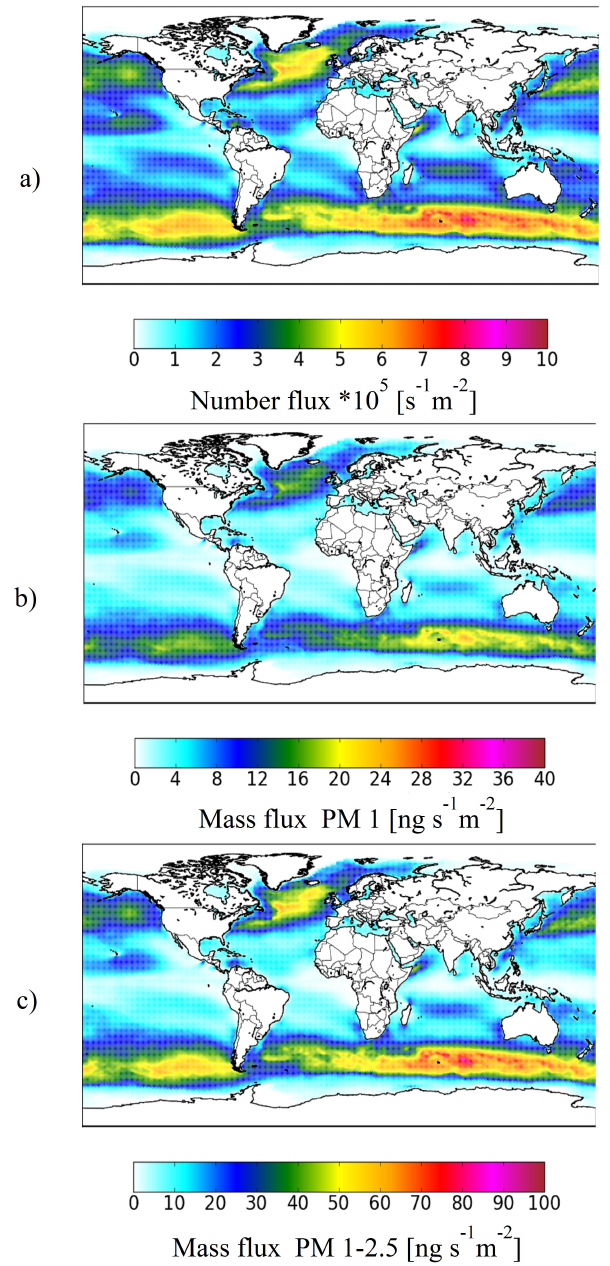
Fig. 9. Annual mean production flux of SSA computed using the OSSA-SSSF together with ECMWF meteorological and wave in- formation: (a) Number flux of particles smaller than 1µm; (b) Mass flux of particles smaller than 1µm; (c) Mass flux of particles be- tween 1–2.5µm.